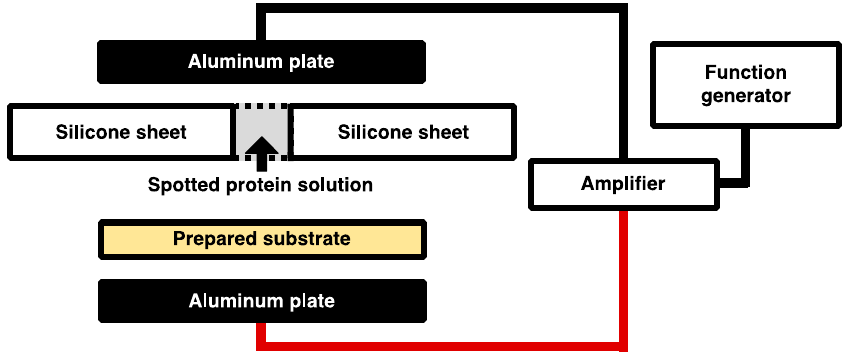
Figure 2. Overview of the experimental system. The AC electric field was generated by an amplifier with a function